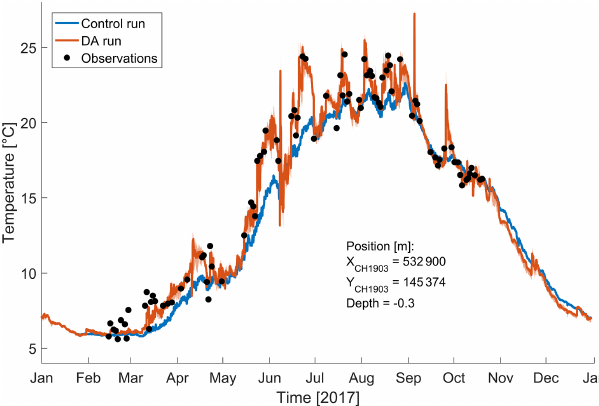
Figure 4. Time series of the LSWT in the center of the lake. The red line corresponds to the mean of the ensemble and the red shaded area to the ensemble spread, while the blue line marks the control run and the black dots the AVHRR observations.